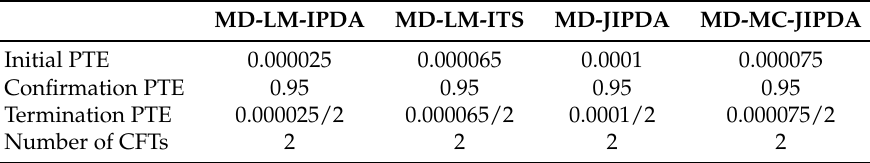
Table 1. Simulation parameters for different